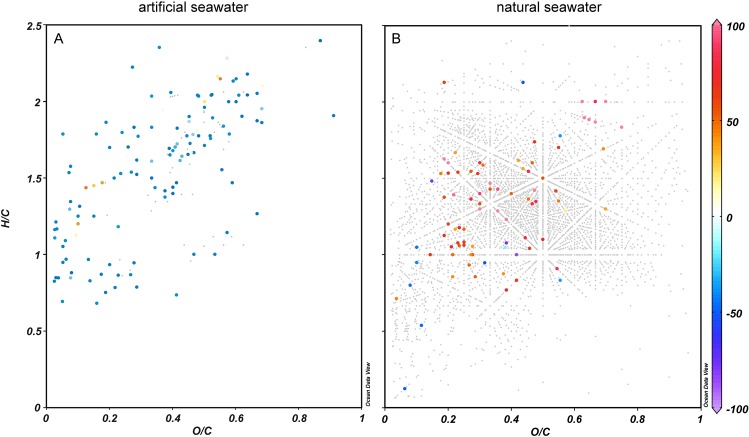
Van Krevelen diagrams (O/C, oxygen to carbon ratio and H/C, hydrogen to carbon ratio of the individual molecular formulas detected) showing the change in DOM composition from t0 to t2 in artificial (A) and natural seawater (B).Changes in normalized relative intensities (%) are color-coded showing a decrease in blue, an increase in red and no significant change during incubation in grey. In both, artificial and natural seawater, different groups of compounds decreased significantly (p < 0.05) during incubation.